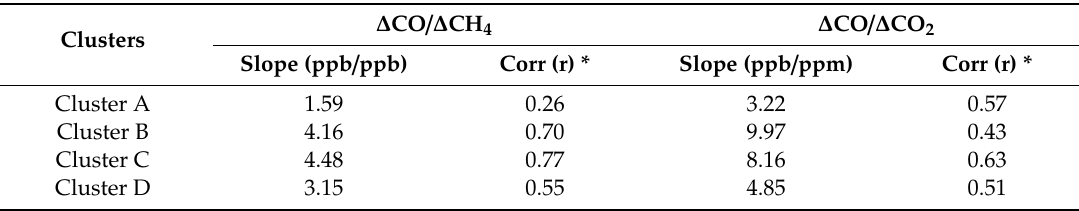
Figure 10. Scatter plots and linear regression for each of the clusters ( a ) between ∆ CO and ∆ CH 4 , ( b ) between ∆ CO and ∆ CO 2 . Table 3. Variations in CO 2 , CH 4 , and CO statistically associated with the di ff erent